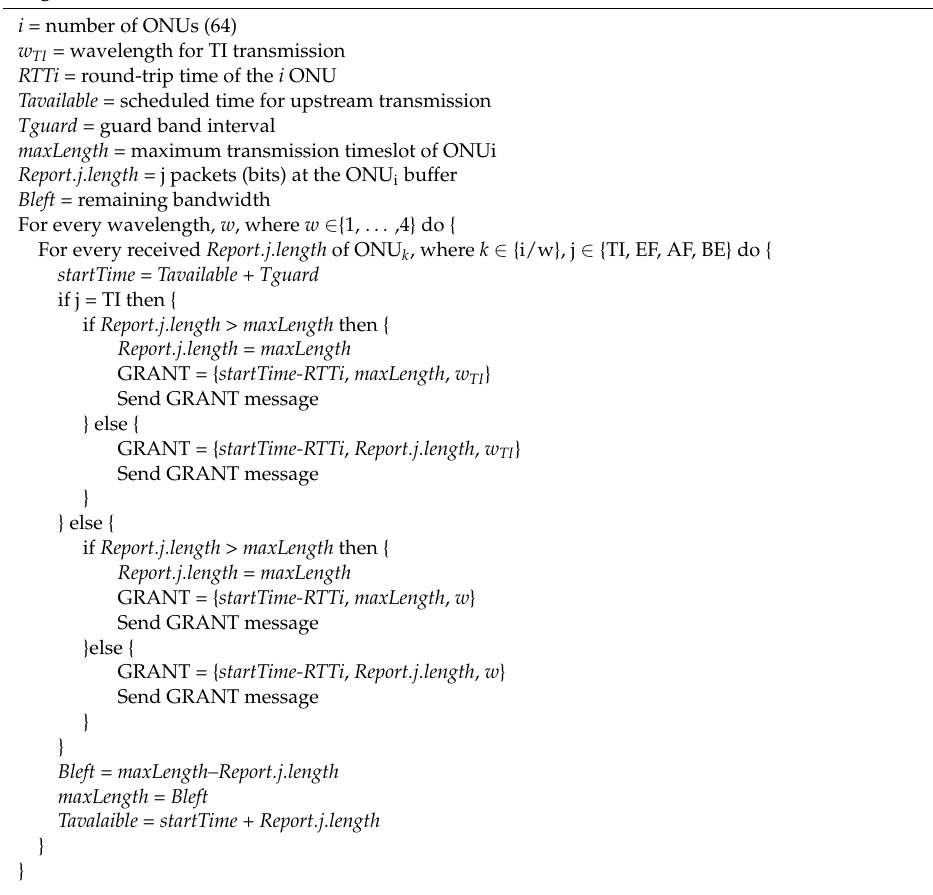
Algorithm 1 Pseudocode for TI-DWBA scheme.